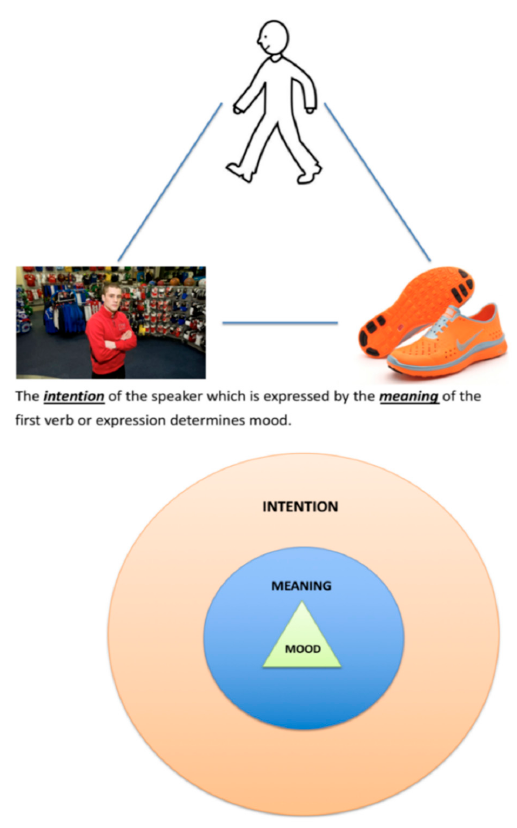
Figure 2. Slide containing the triangle with the shoes, Juan, the shop assistant, and the concepts of mood, meaning, and intention.